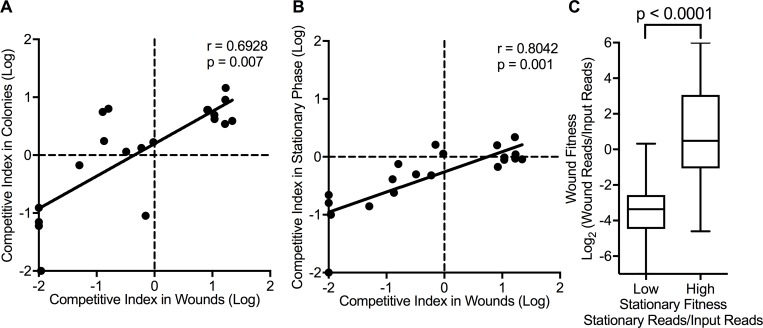
High-density growth and wound fitness correlate.(A and B) Relationship between the competitive index of mutants in colonies (A) or stationary phase cultures (B) and in wound infections. Spearman correlation and significance values were calculated using mean competitive index of each mutant. C. The wound competitive index of the 100 mutants exhibiting the lowest and highest stationary phase culture fitness (as measured by Tn-seq). Box plots indicate median, and 25th and 75th percentiles; error bars show the range of wound competitive index. Significance determined by Mann-Whitney analysis.